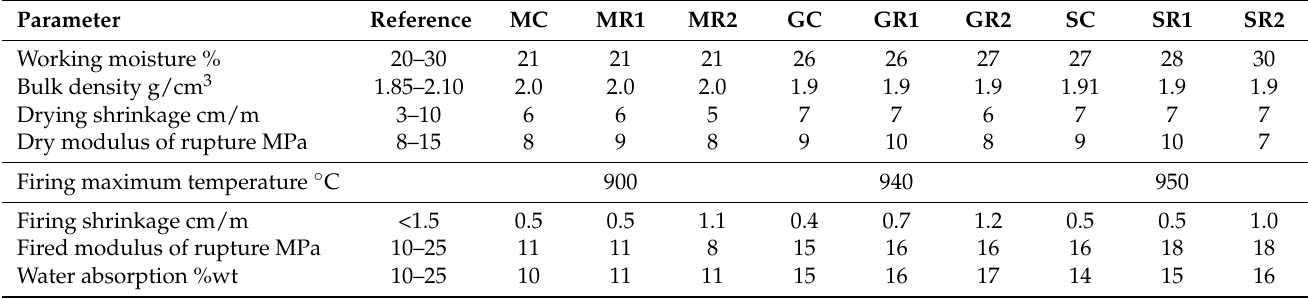
Figure 4. Radar graph of the main physical and technological properties normalized respect to the reference bodies (MC-SC-GC) for addition of waste R1 ( left ) or R2 ( right ). Table 6. Comparison between the main physical and technological properties.